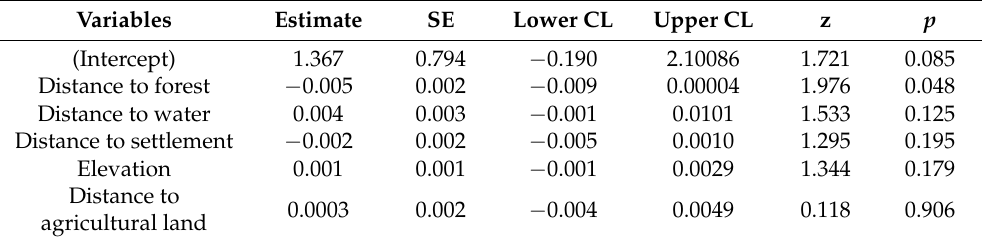
Table 2. Model-averaged parameter estimates and lower and upper 95% confidence limits describing the occurrence of Egyptian vultures in Nepal. Parameter estimates were averaged from all models reported in Table